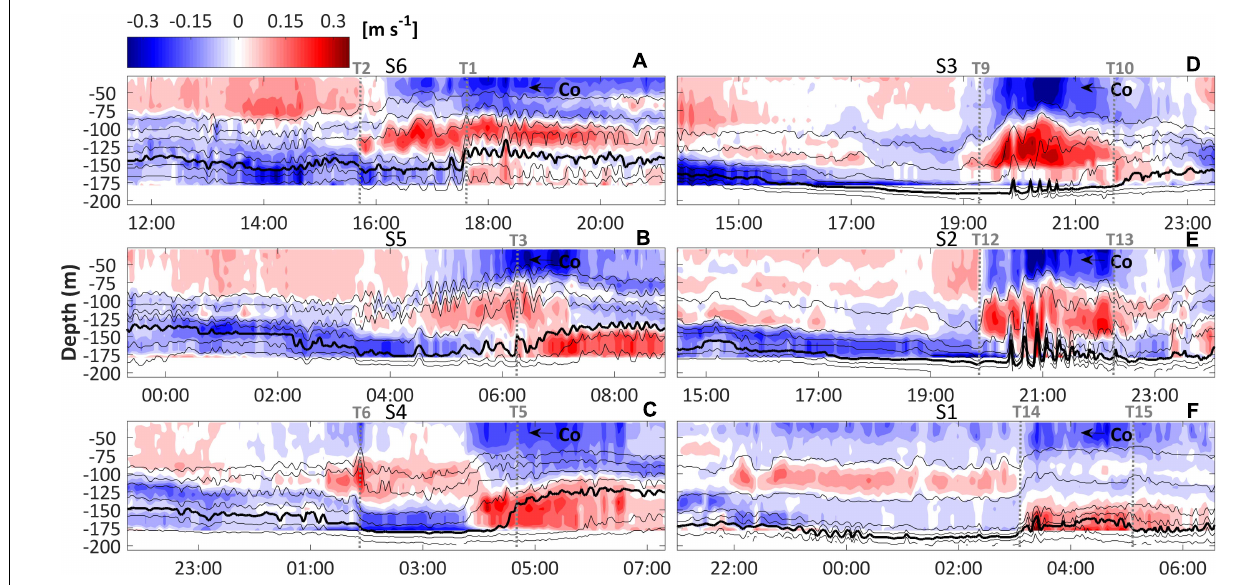
FIGURE 8 | As in Figure 6 , but for (A–F) baroclinic onshore velocity field.